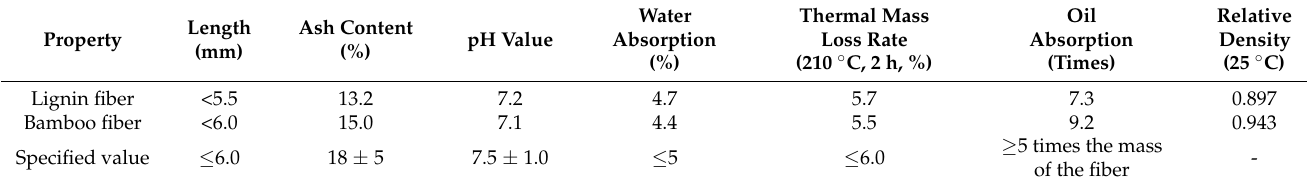
Table 2. Basic properties of the two fibers used in this